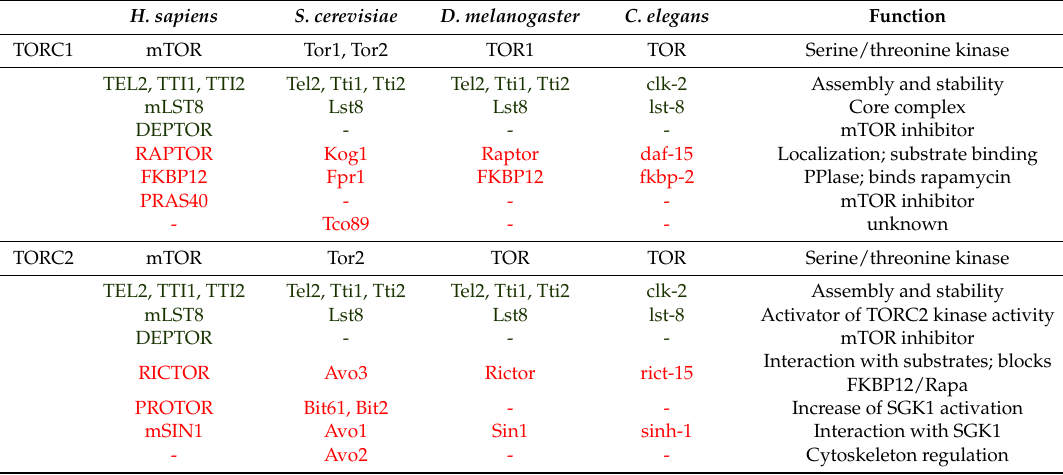
Table 1. Function and evolutionary conservation of TOR complex constituents. The table lists the constituents of TORC1 and TORC2 in different species and describes their molecular function. Common factors are in green, while unique factors are in